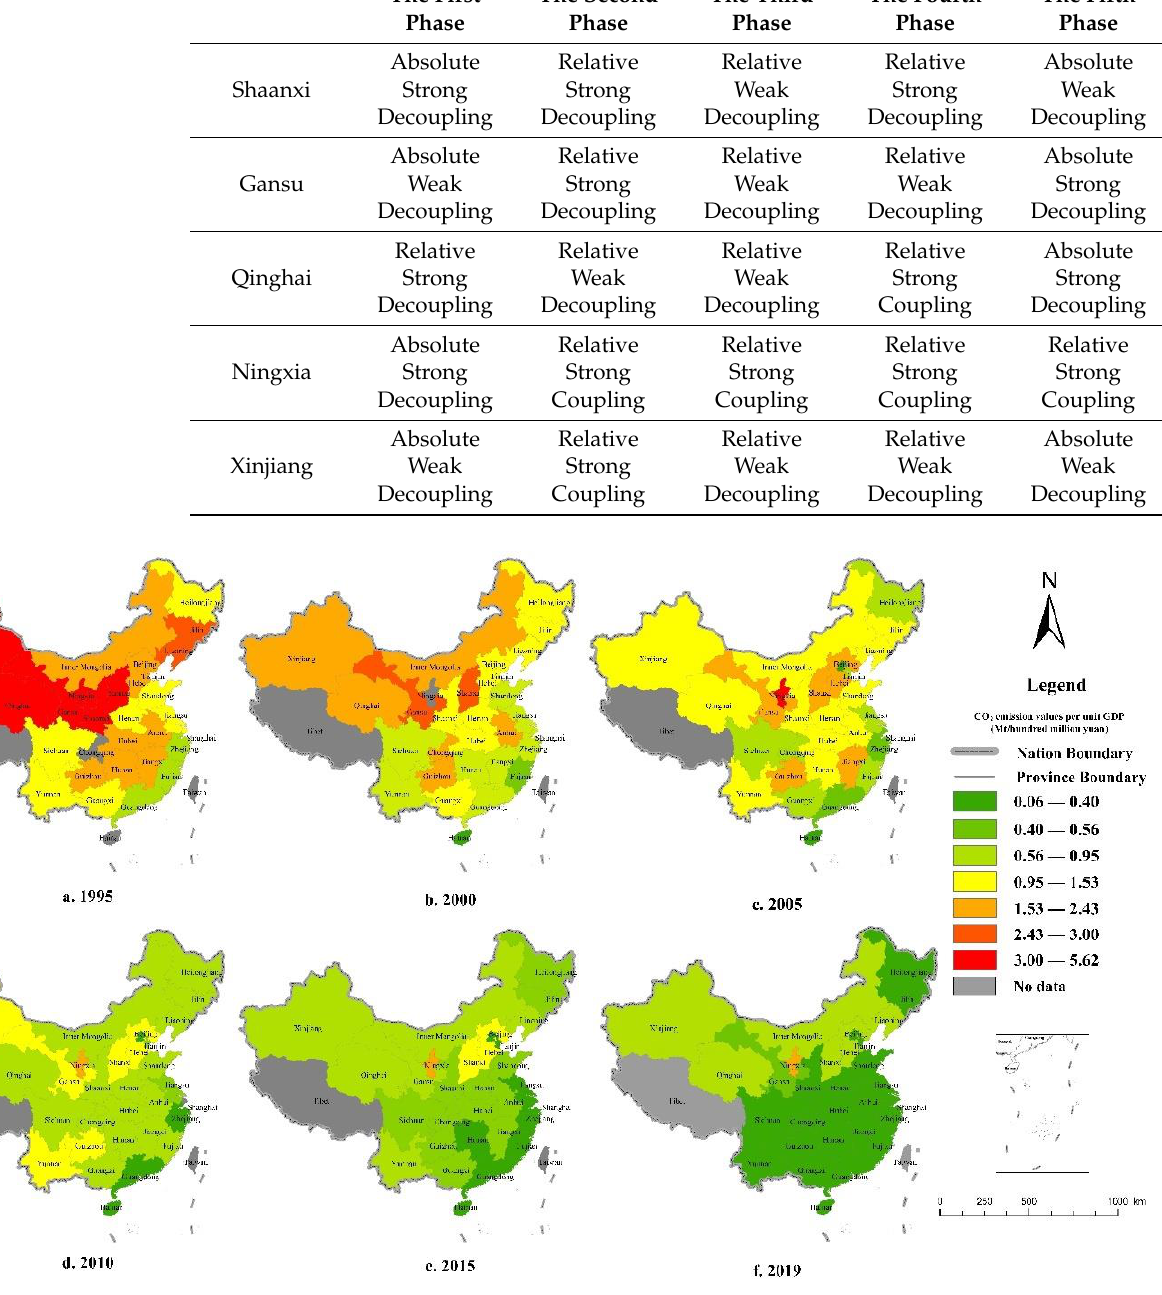
Figure 6. Industrial CO 2 intensity at the provincial level during 1995 – 2019.